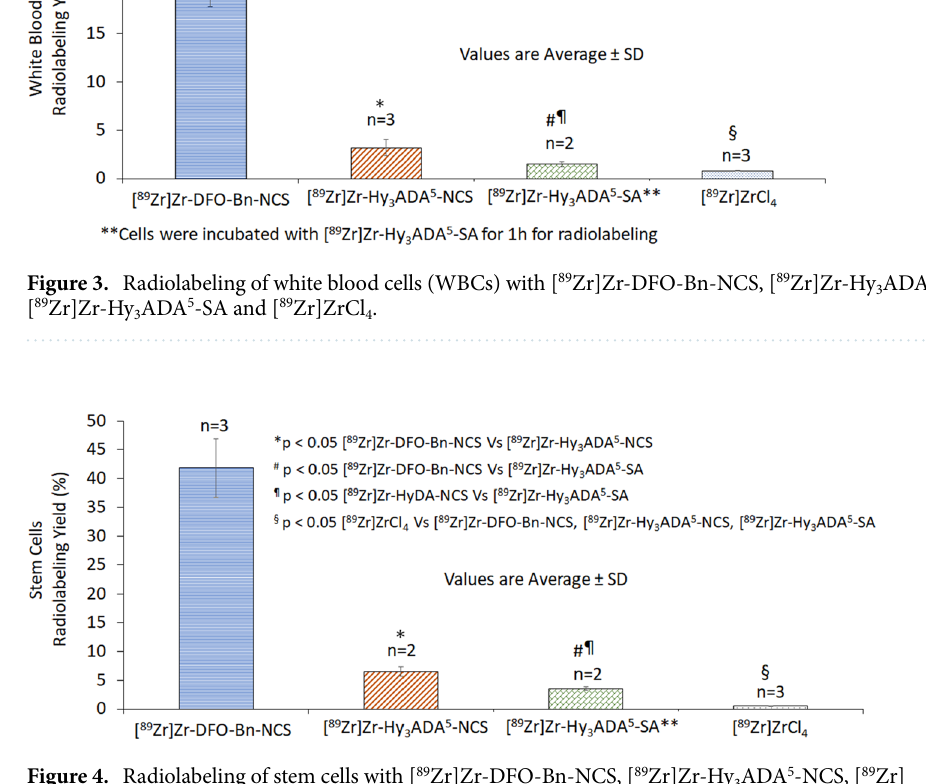
Figure 4. Radiolabeling of stem cells with [ 89 Zr]Zr-DFO-Bn-NCS, [ 89 Zr]Zr-Hy 3 ADA 5 -NCS, [ 89 Zr] Zr-Hy 3 ADA 5 -SA and [ 89 Zr]ZrCl 4